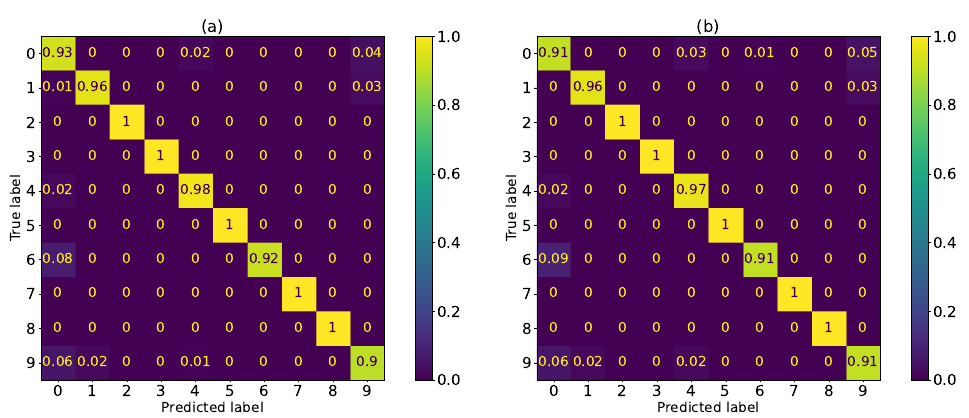
Figure 10. Confusion matrix with results of accuracy for each fault case for the training data ( a ) and test data ( b ) with 10 different parameter sets. 0: healthy state; 1: undervoltage; 2: unsymmetrical voltage; 3: open phase; 4: broken bar; 5: winding short circuit; 6: mixed eccentricity; 7: bearing—outer ring fault; 8: bearing—inner ring fault; 9: bearing—global fault.